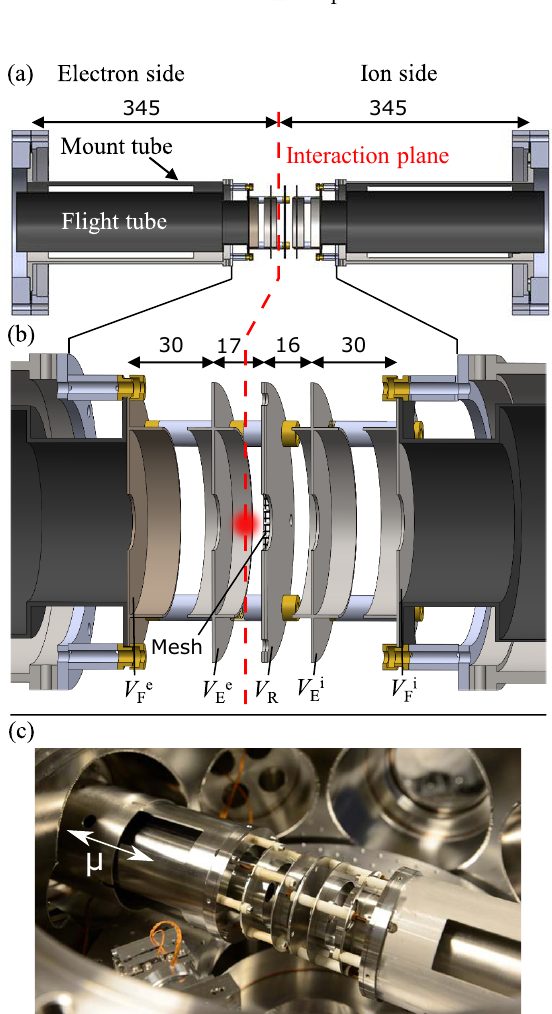
Figure 1. Drawing of the double velocity map imaging spectrometer (VMIS) ( a ) and an expanded view of the electrode package ( b ); dimensions are in mm. The indicated voltages are applied to the electron side flight tube ( V e ), the electron side extractor ( V e ), the repeller ( V R ), the ion side extractor ( V i F E the ion side flight tube ( V i ). A photo of the spectrometer mounted in the experimental chamber is F shown in ( c ). The sliding µ -metal shield is marked by the letter µ